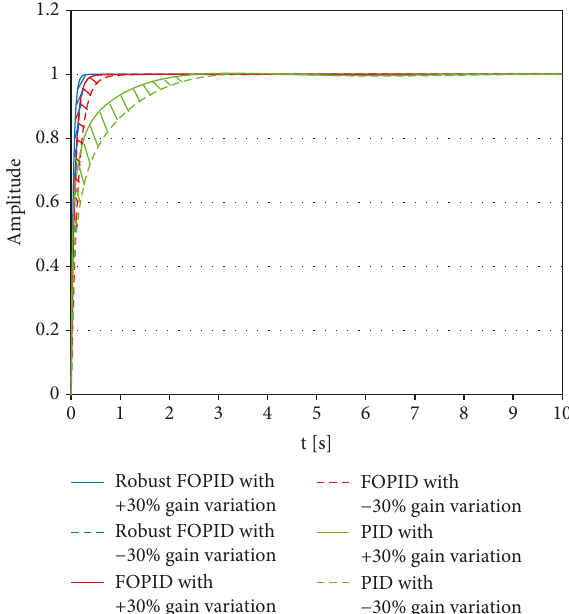
Figure 11: Step response comparison of G uncertainties.